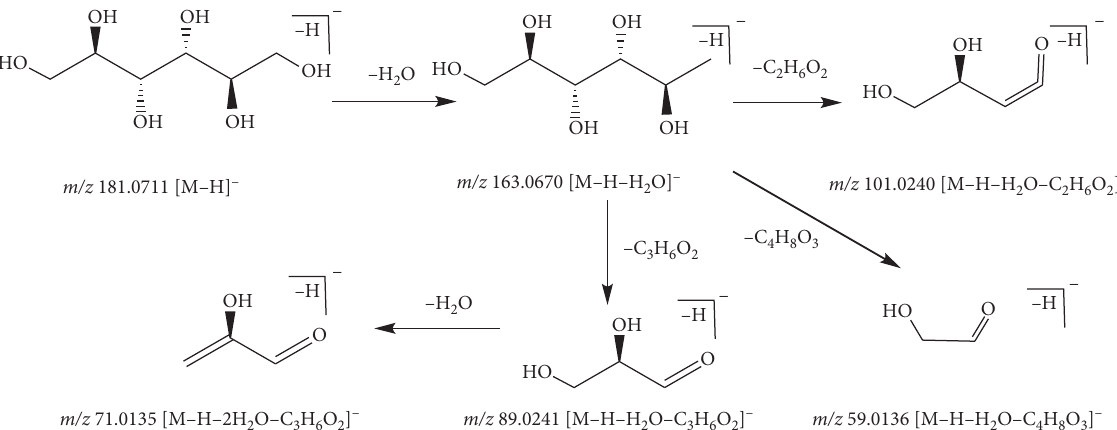
Figure 9: Possible fragmentation pathway of compound